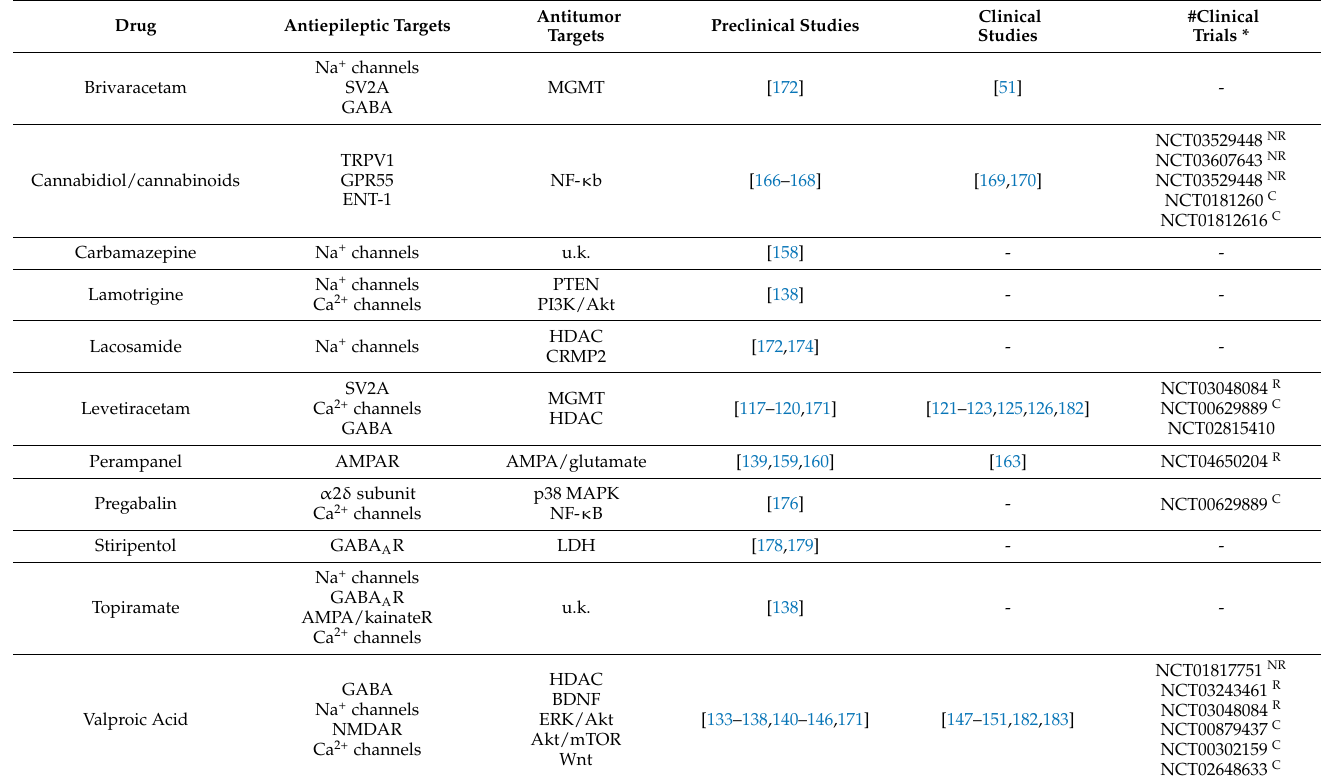
Table 1. Suggested targets and antitumor efficacy of antiepileptic drugs in